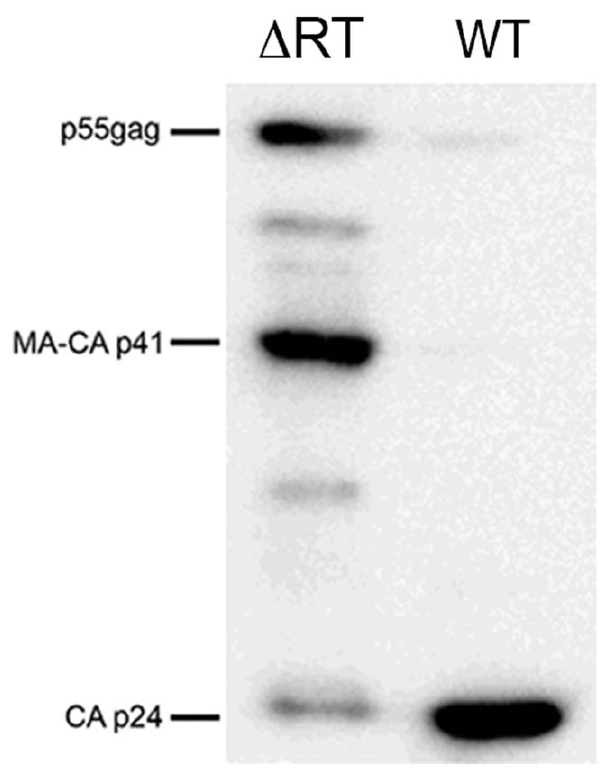
Figure 4. Protein profile of NL4-3 and NL4-3/ D RT virions. Virions purified by ultracentrifugation were used to extract proteins and separated in a gradient 4-12% Tris-Glycine gel. An anti-p24 monoclonal antibody was used to study the processing profile of Gag in NL4-3/ D RT and NL4-3 virions. There is a weaker processing of Gag in NL4-3/ D RT virions, represented by an increase in p55- gag and MA-CA p41 forms in detriment of CA p24. At the same, an increase in intermediate forms is also shown in NL4-3/ D RT virions.